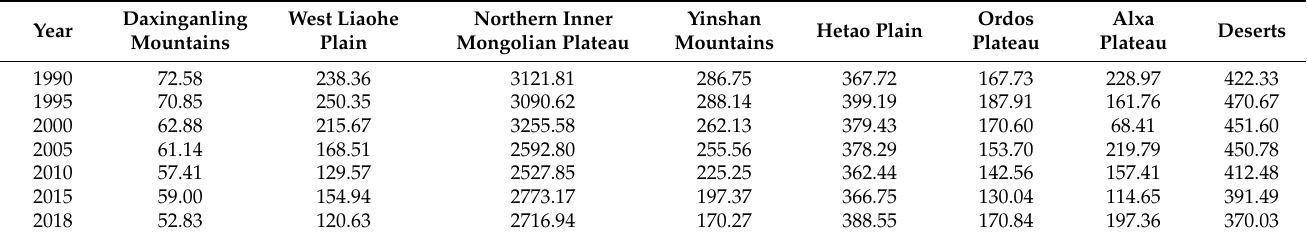
Table 4. Total area of lakes with individual areas of >1 km 2 in the different geomorphological